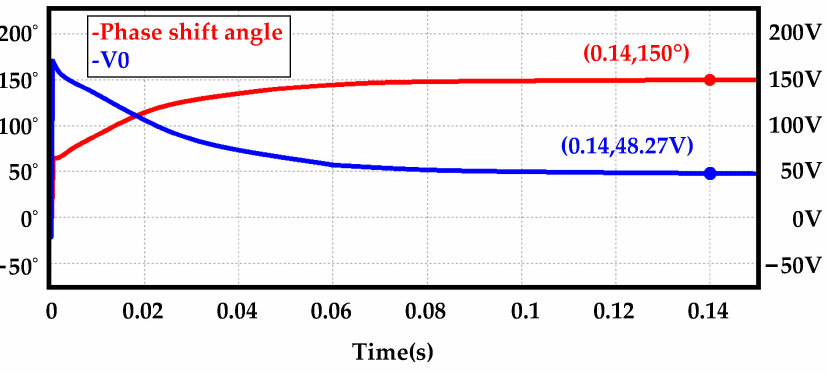
Figure 14. The waveform of output voltage and the phase shift angle in the optimized circuit.